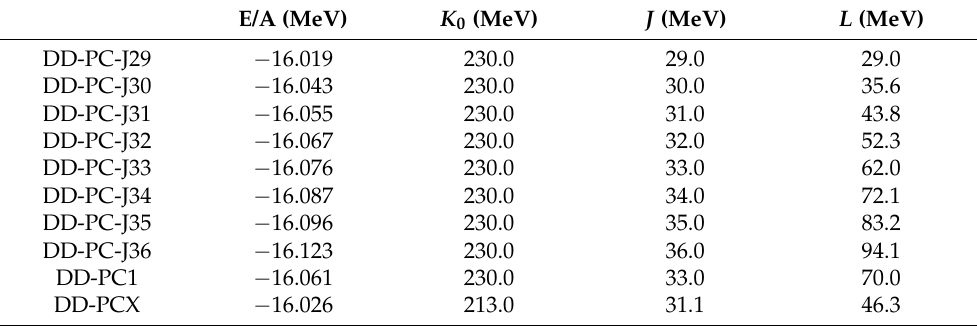
Table 3. The nuclear matter saturation properties for the DD-PC family of interactions spanning the range of symmetry energy J and L values. In addition, the properties for the DD-PC1 [4] and DD-PCX [26] functionals are